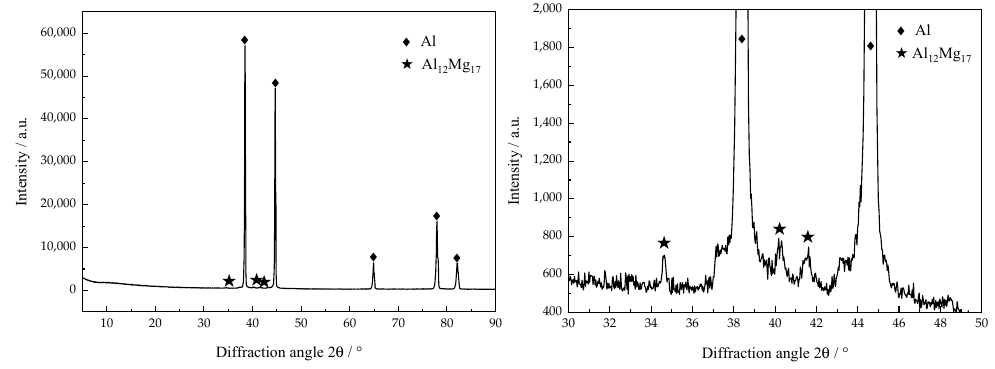
Figure 5. XRD pattern of Al-Mg alloyed additive.